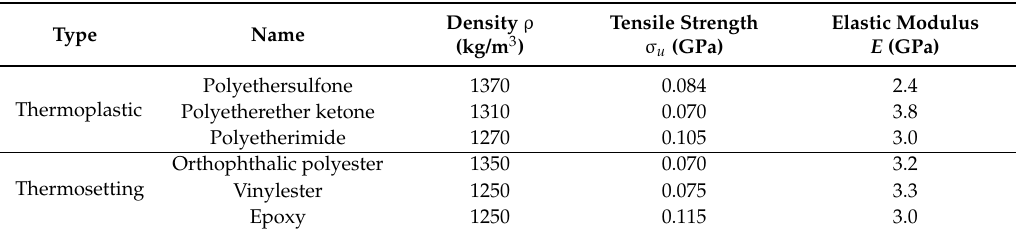
Table 2. Mechanical properties of commonly used polymer resins.